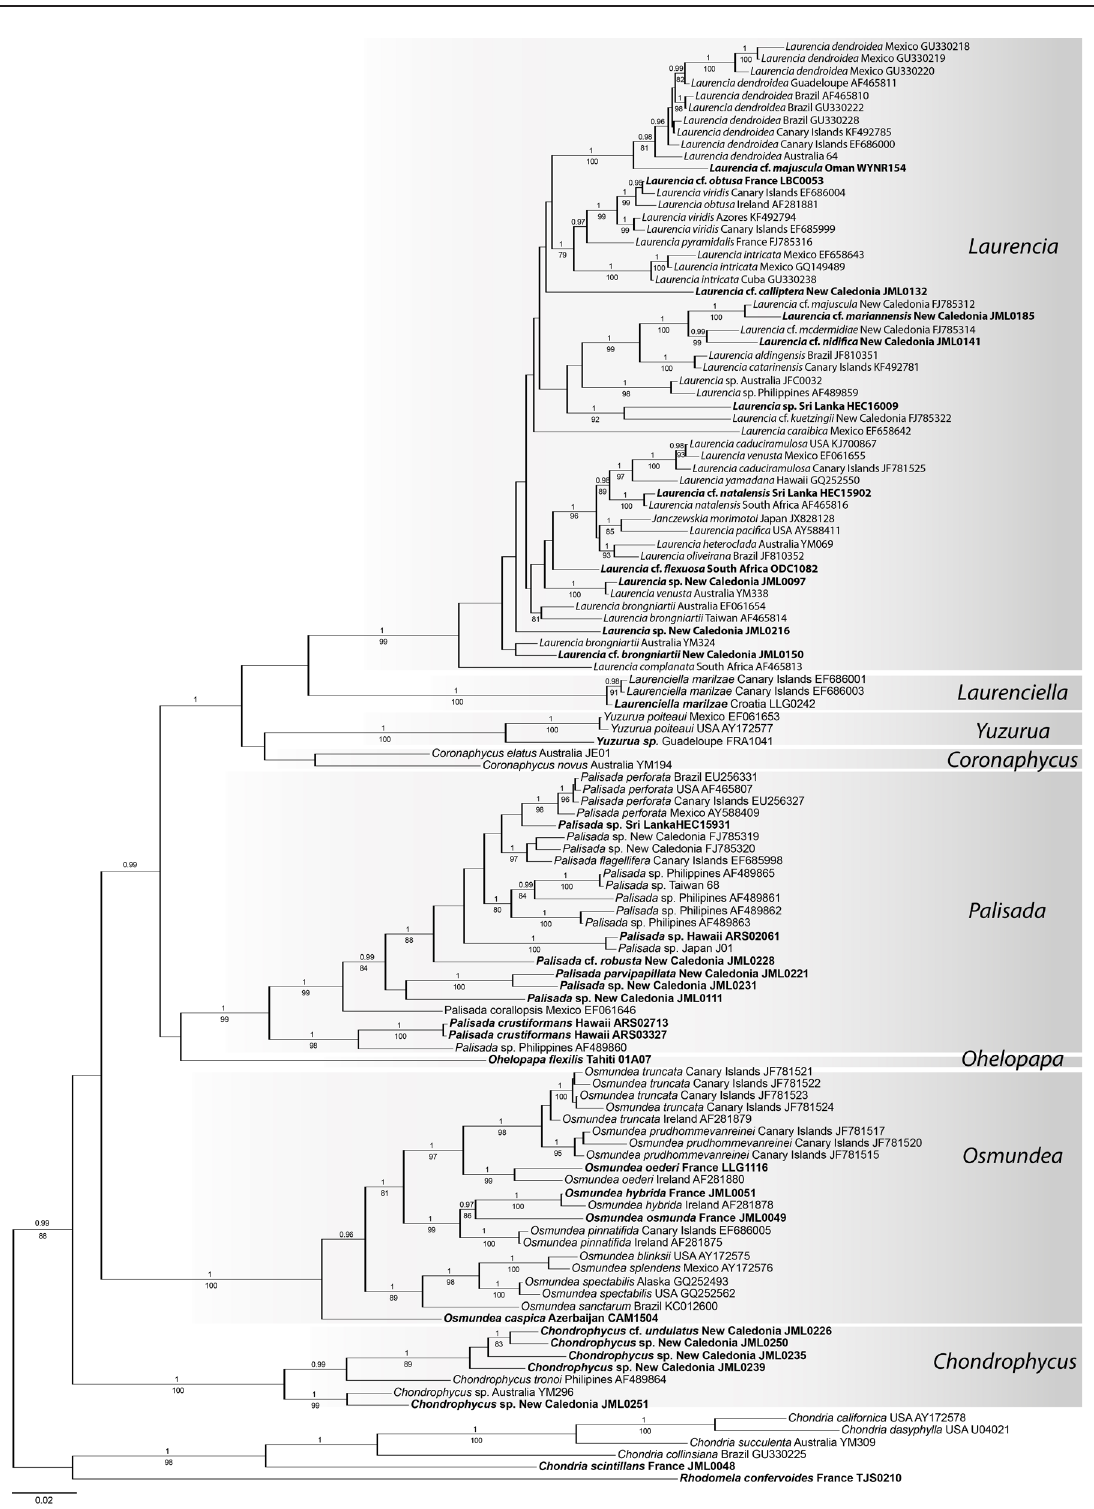
Fig. 1. Tree inferred from rbc L using Bayesian analysis (BI) and including 111 specimens of members of the Laurencia complex and six outgroup taxa. The numbers above branches indicate Bayesian posterior probabilities (pp) and below branches indicate bootstrap values (bp) inferred from 1000 ML bootstrap replicates (ML); pp < 0.95 and bp < 75% are not shown. Taxa for which new sequences were produced are indicated in